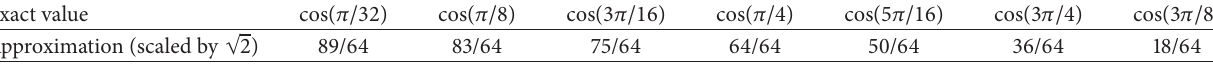
Table 1: Multiplicands required in the 8-point Chen’s fast DCT algorithm.